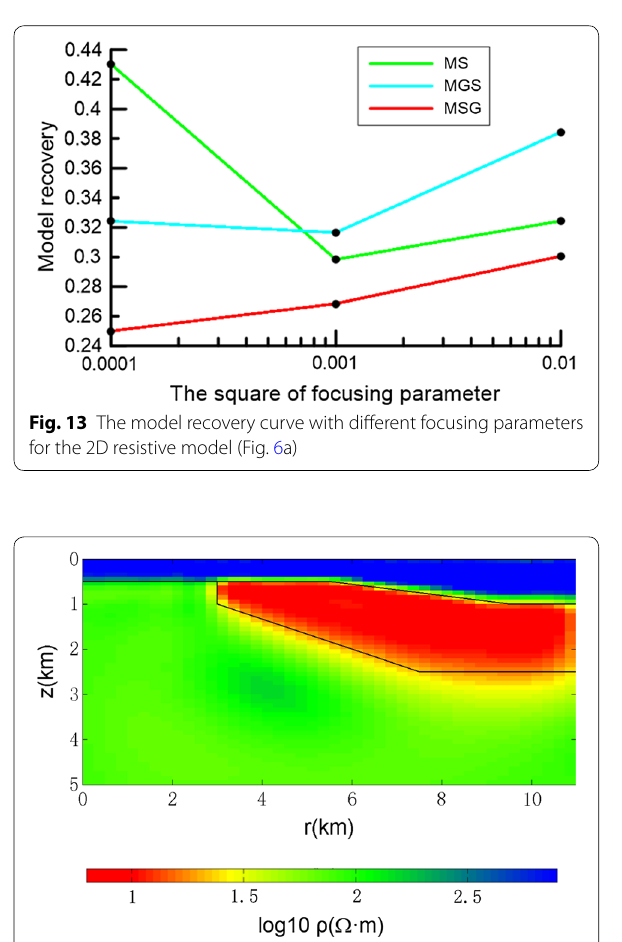
Fig. 14 A synthetic (a) inversion result with the MSG stabilizer for the 2D conductive wedge model (Fig. 6b). Color scale is the same as that in Fig.